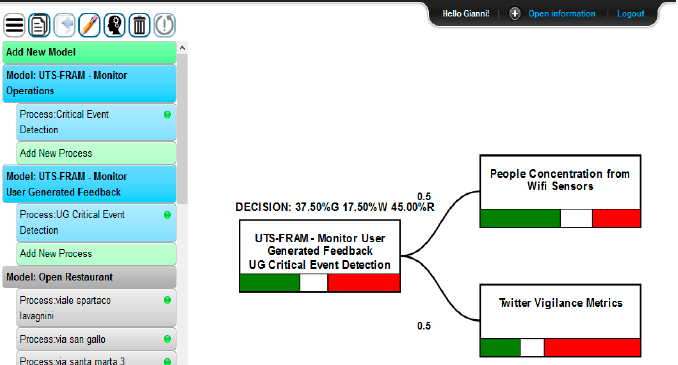
Figure 20. SmartDS decisional process implementation as to the Monitor User-Generated Feed- back (represented in the FRAM sub-set in Figure 17). http://smartds.disit.org/dss/ also used in Snap4City Https://www.snap4city.org.